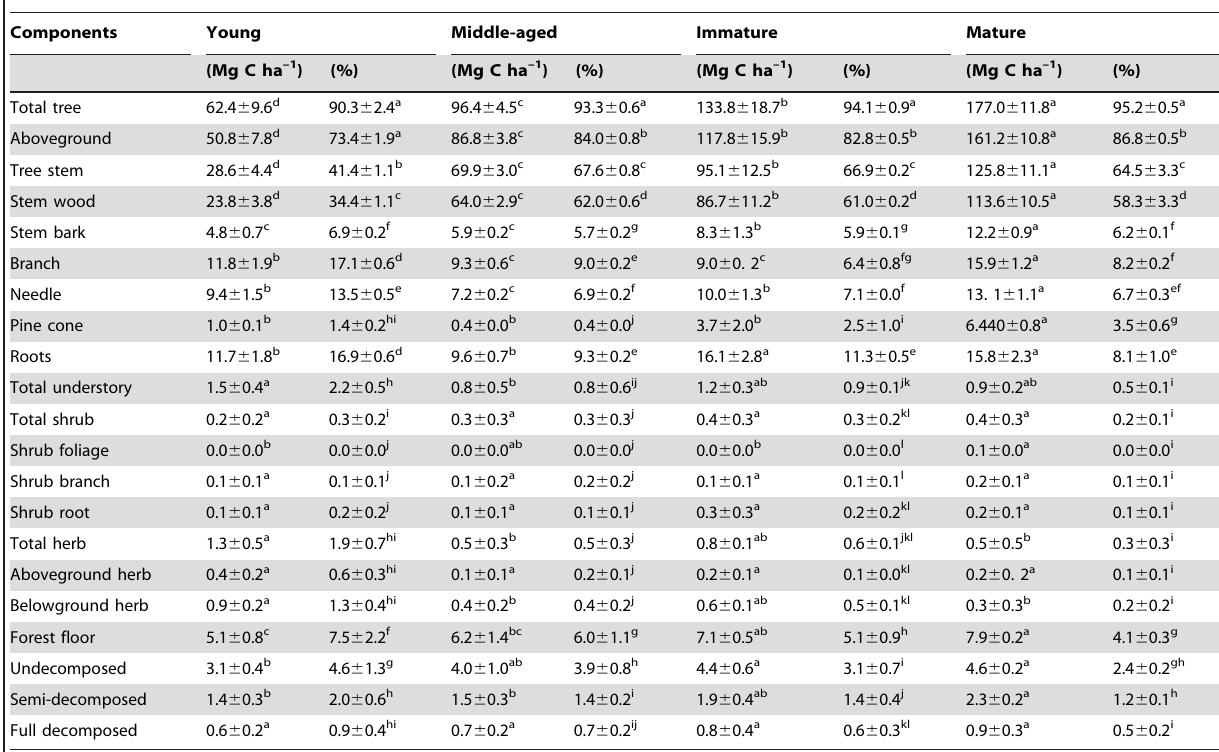
Table 4. C pools of different biomass components in P. tabulaeformis forests.